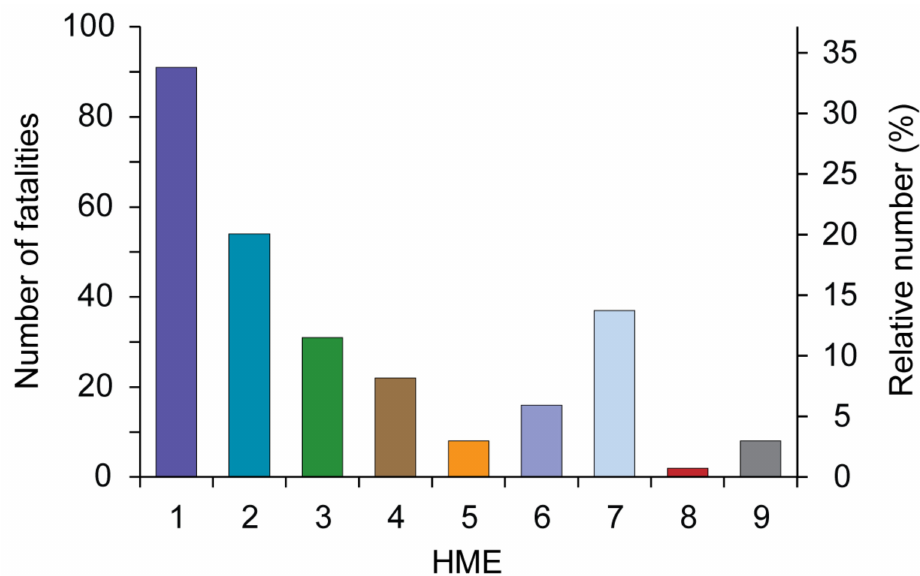
Figure 4. Absolute and relative numbers of fatalities related to individual types of hydrological and meteorological event (HME) in the Czech Republic during the 1981–2018 period: 1—flood, 2—flash flood, 3—windstorm, 4—convective storm, 5—lightning, 6—frost, 7—snow / glaze-ice, 8—heat, 9—other